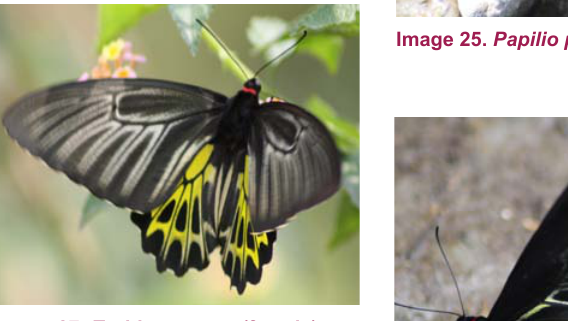
Image 27. Troides aeacus (female)